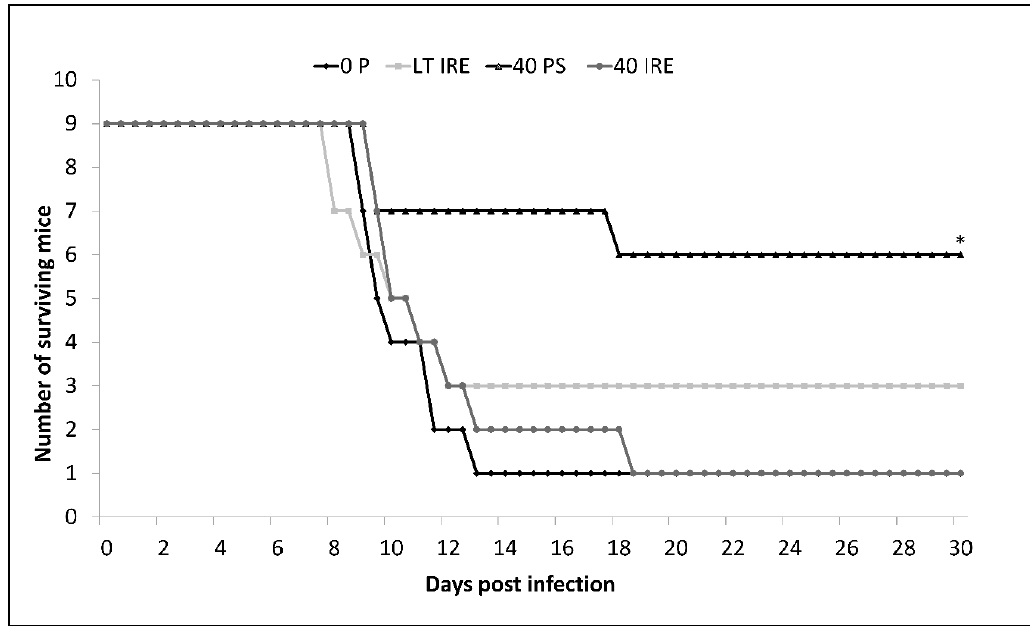
Figure 3. Survival curve of CD1 mice after subcutaneous inoculation with 100 PFU of parental TBEV strain 0 P (dark line with diamonds) or virus variants 40 IRE (light line with circles), 40 PS (dark line with triangles), and LT IRE (light line with squares). Mice infected with 40 PS had significantly prolonged median survival times and lower mortality rates when compared to other viral strains. Statistical significance was tested using Fisher ’s Least Significant Difference (LSD) post hoc test (* p < 0.05) .